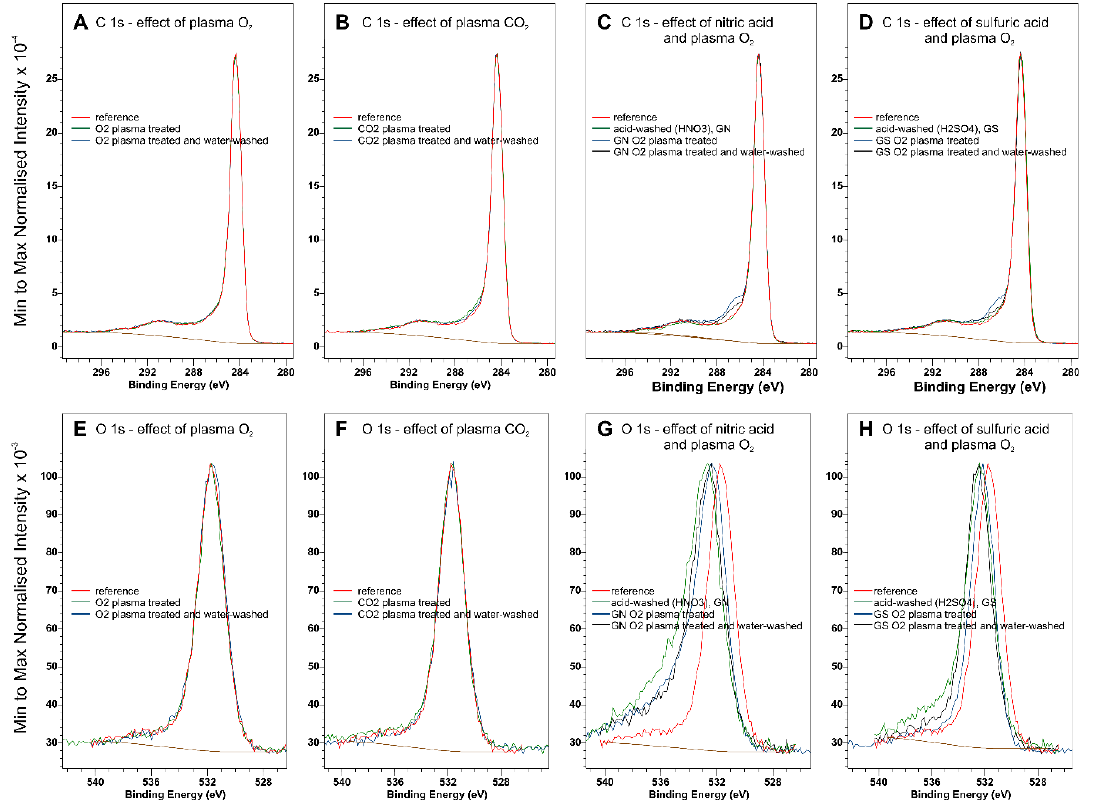
Figure 7. XPS core C 1 s and O 1 s spectra of graphite treated with O 2 plasma ( A , E ), CO 2 plasma ( B , F ), nitric acid ( C , G ), and sulfuric acid ( D , H ).